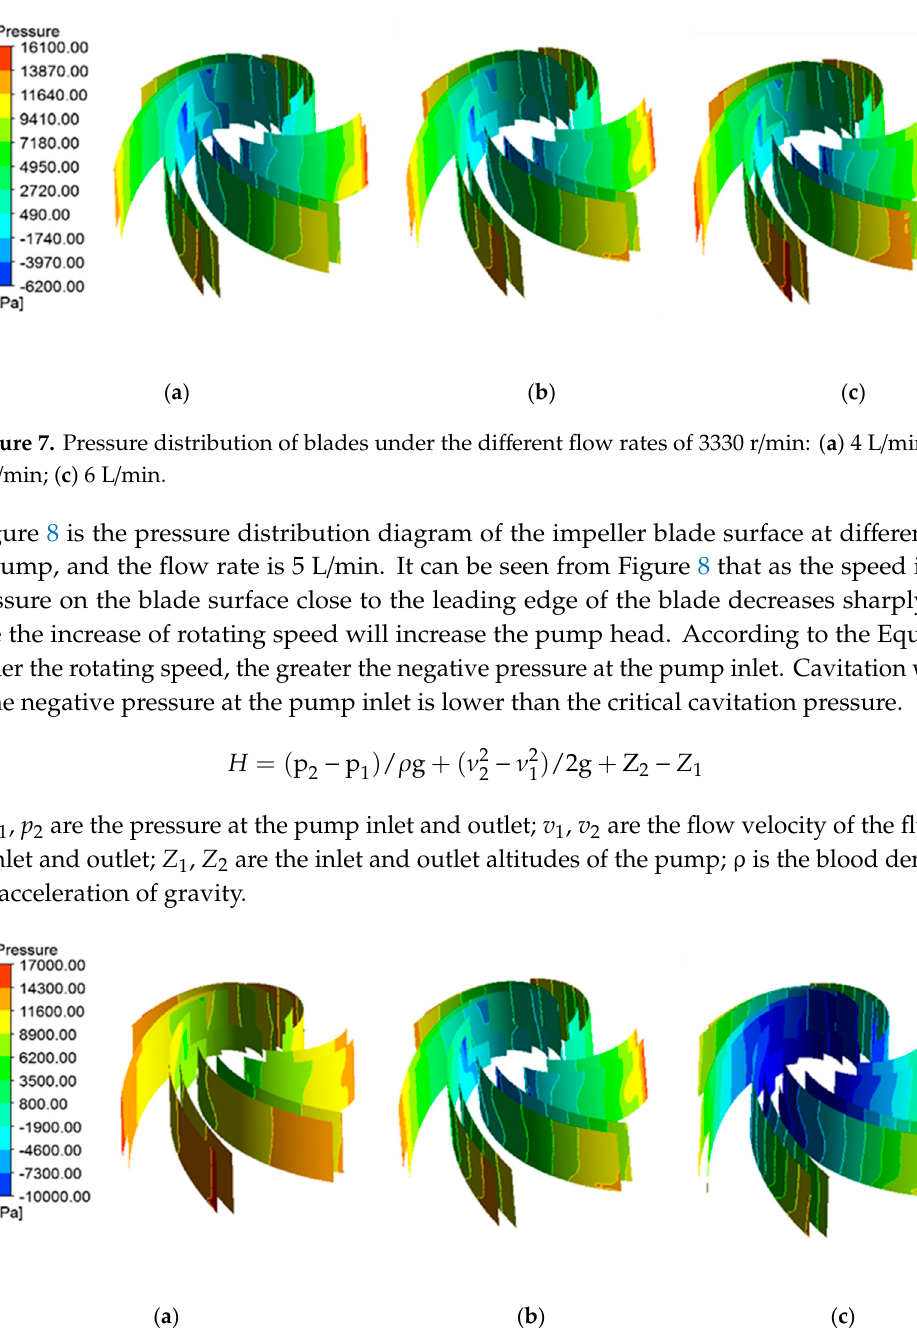
Figure 6. Performance characteristic of the centrifugal blood pump.